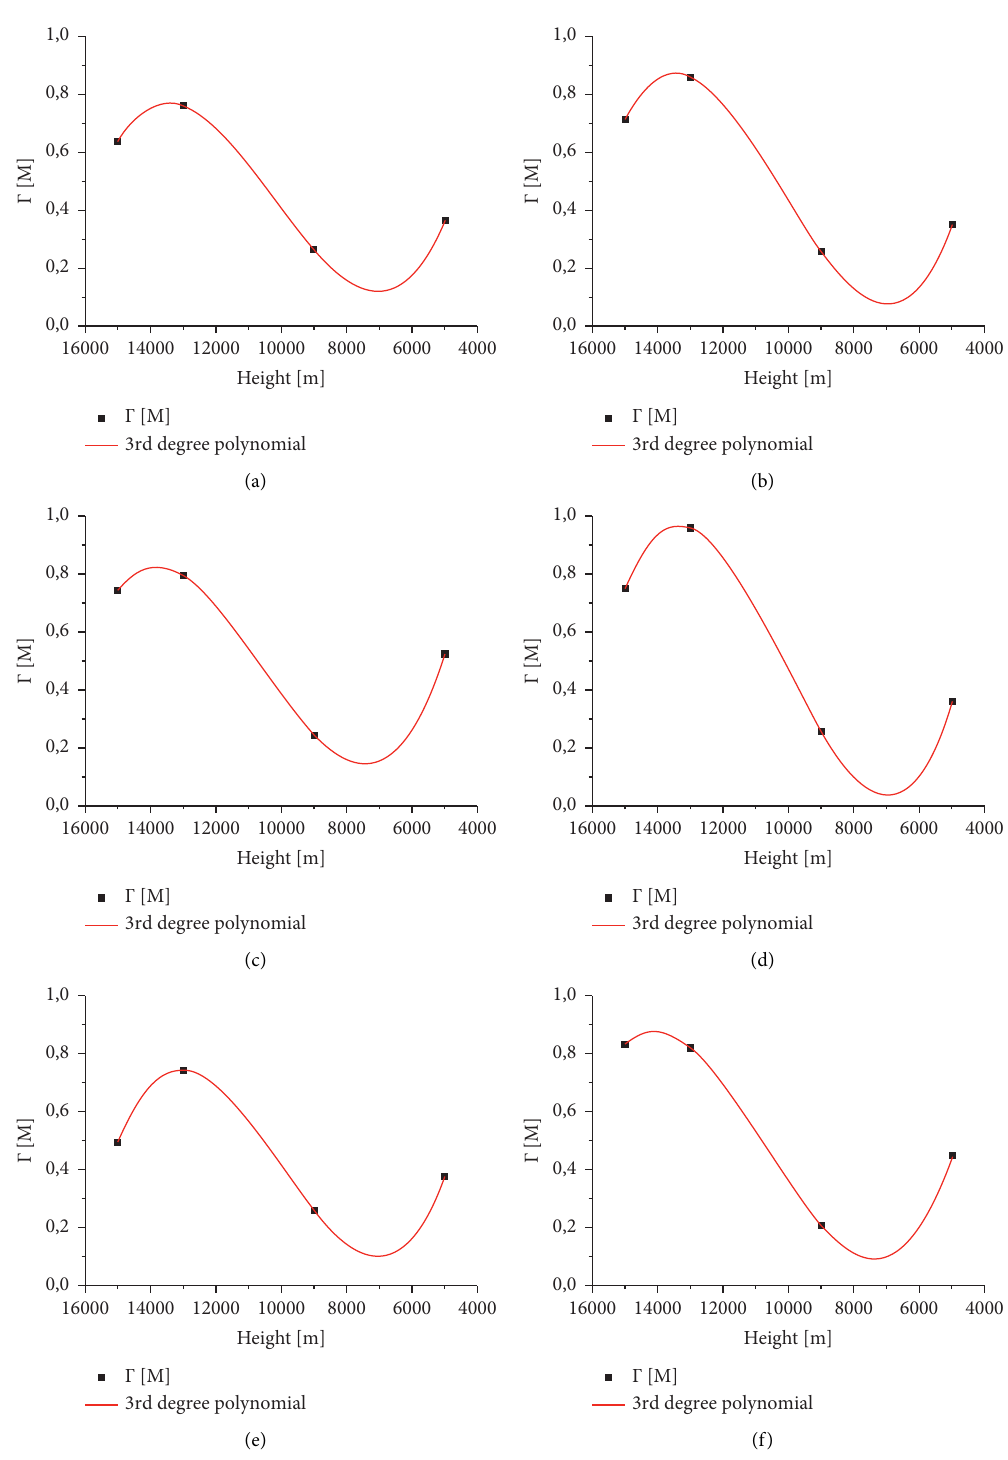
Figure 6: Dependence of drag coefficient Γ (h) on altitude change for the largest fragment of the Koˇsice meteorite (2370 g in 6 different orientations). The graph shows the apparent variability of the drag coefficient Γ (h) when changing the altitude, where also the velocity was decreasing. (a) X . (b) IX . (c) Y . (d) IY . (e) Z . (f) IZ fragment leads to a lower drag coefficient value and less effective deceleration in the lower atmosphere. At an altitude of 17.4 km, the body enters into the dark phase of flight with a speed of 2.5 km/s. This value is identical to the fragment no. Figure 1. At the same time, the nearly spherical shape of the